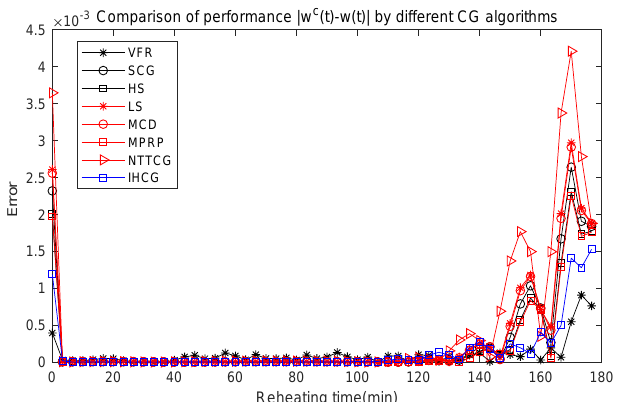
Figure 7. Comparison of performance | w c ( t ) − w ( t ) | by different CG